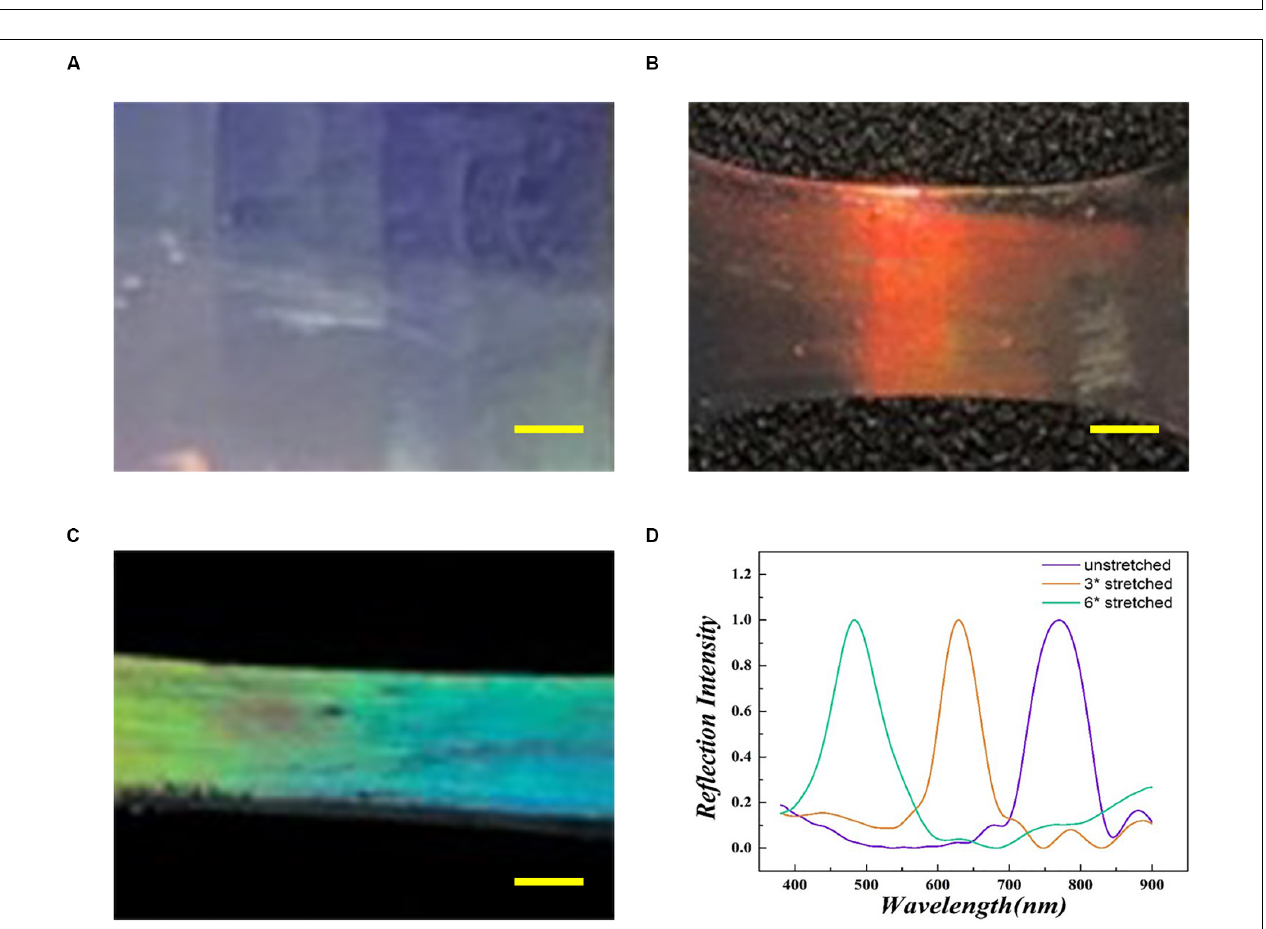
FIGURE 1 | Materials characterization. (A) Schematic illustration of the manufacturing process of the anisotropic inverse opal substrates; the SEM images of the PVDF control substrate (B) , the inverse opal substrate (C) , the 3 × stretched substrate (D) , and the 6 × stretched substrate (E) . Scale bars are 1 mm in panels (B–E) .